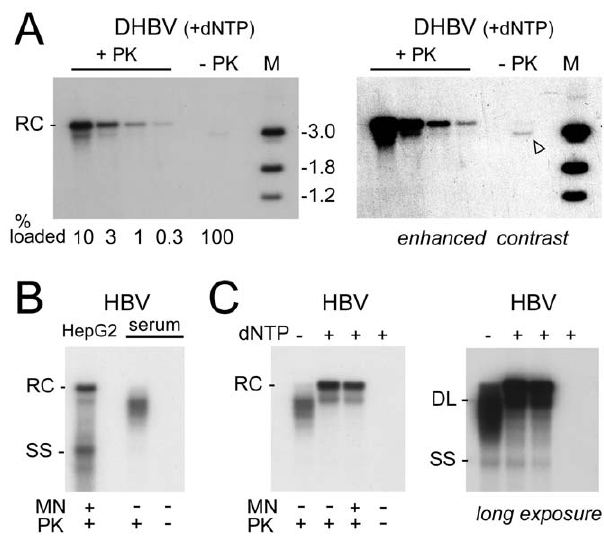
Figure 9. Efficient plus-strand DNA extension does not induce uncoating and polymerase removal from rcDNA. Nucleocapsids were obtained by detergent-stripping of virions from highly viremic sera and subjected to a 16 h endogenous polymerase reaction (EPR; + dNTP) as described [26]. ( A ) DHBV. After the EPR, viral DNA was prepared via phenol extraction with or without prior PK treatment. All of the non-treated and the indicated fractions of the PK-treated sample were loaded on a gel and analyzed by Southern blotting. A very long exposure plus contrast enhancement (right panel) revealed a faint band at the dlDNA but not the rcDNA position. ( B ) Comparison of electrophoretic mobility of transfection-derived and virion-derived HBV DNA. Cytoplasmic DNA from transfected HepG2 cells and virion DNA (prior to EPR) was treated as indicated, isolated via phenol extraction, and analyzed by Southern blotting. Note the faster mobility of most virion-derived DNAs, indicative of incompletely extended plus- strands, and the virtual absence of signal without prior PK treatment. ( C ) HBV EPR products. Nucleocapsids subjected to long-term EPR conditions were treated as indicated. The shift towards the positions of full-length rcDNA and dlDNA after the EPR indicated that the nucleocapsid-borne polymerase was active. Nearly all DNA was resistant towards MN. Even an overexposed autoradiogram (right panel) did not reveal a signal without prior PK